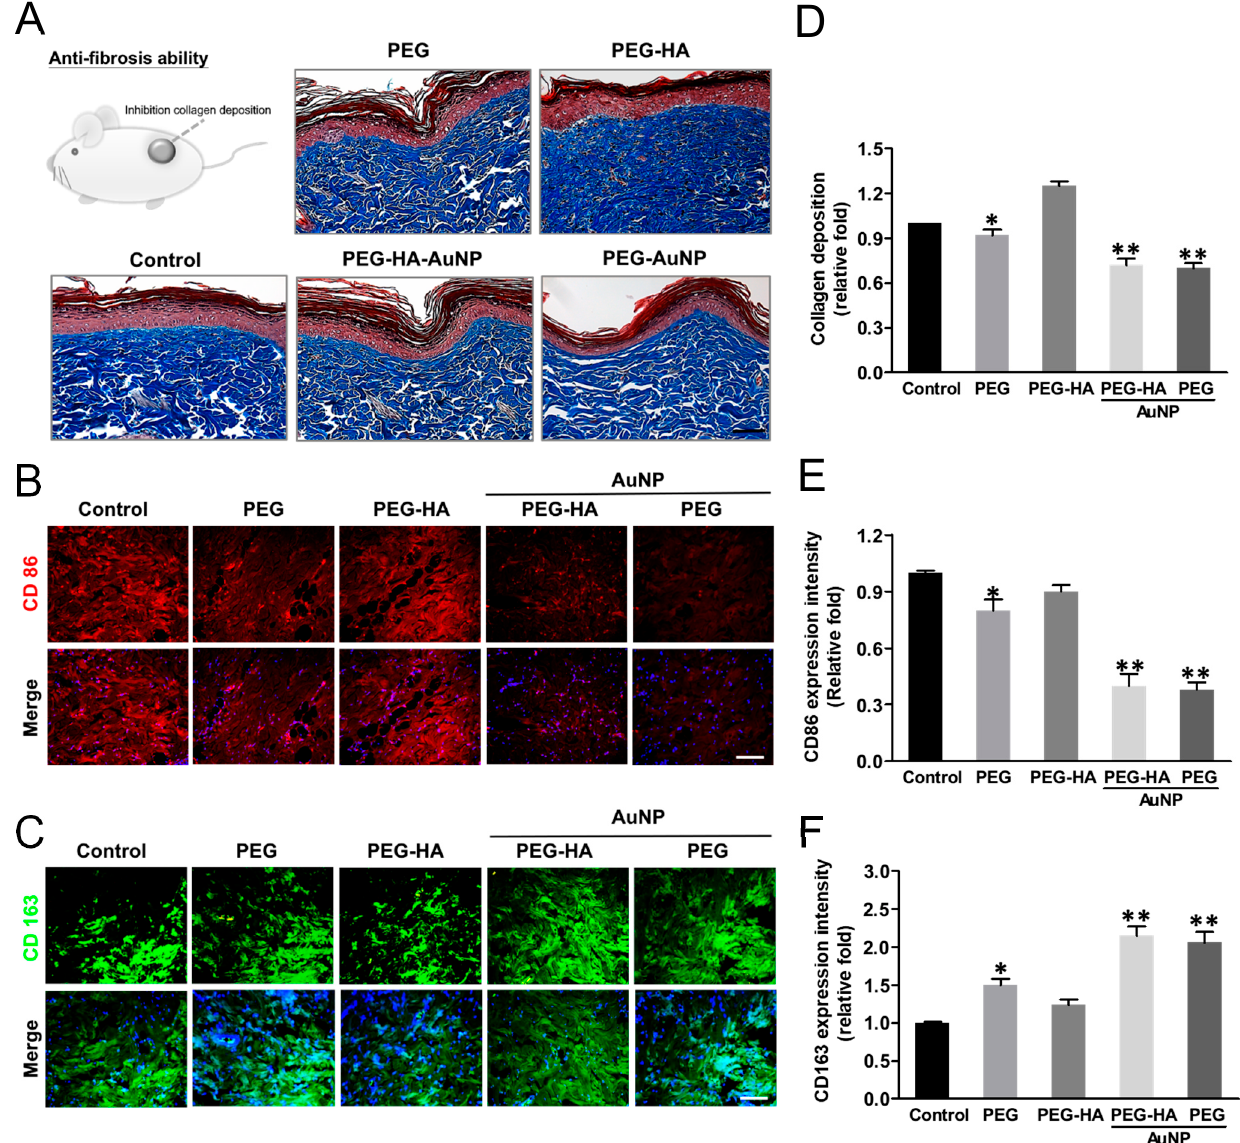
Figure 10. Masson’s trichrome staining of ( A ) collagen deposition (blue color) of rat femoral artery subcutaneously implanted in an SD rat assessed the immune response of different materials at 4 weeks. Immunofluorescence staining images (marker of macrophages) in response to the implant materials. ( B ) CD86 (M1) = red color, ( C ) CD163 (M2) = green color. The scale bar represents 100 µ m. Quantification of ( D ) collagen deposition, and ( E ) CD86 and ( F ) CD163 fluorescence intensities. Data are mean ± SD. * p < 0.05, ** p < 0.01: smaller or greater than control group (glass). The number of rats was 5 ( n = 5).